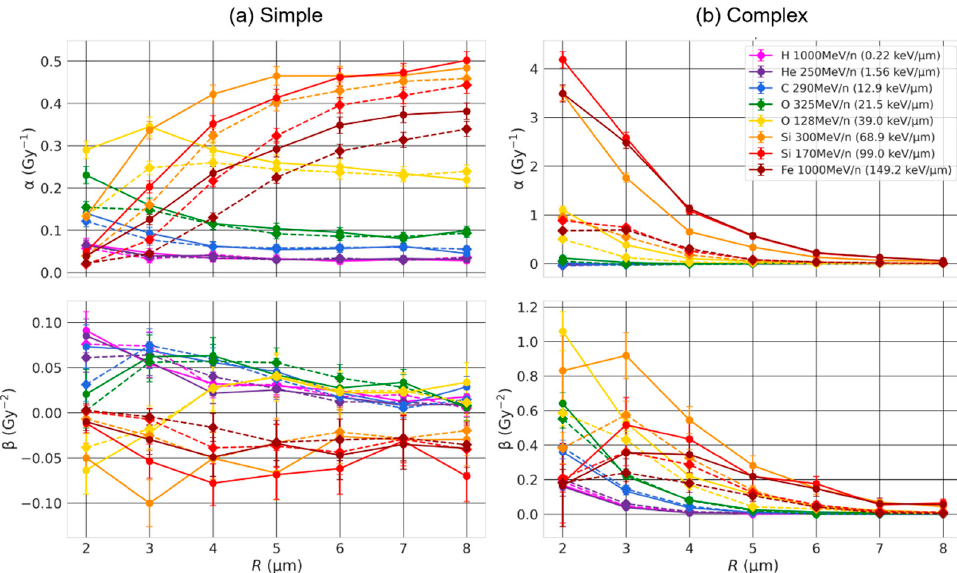
Figure 6. 𝛼 and 𝛽 coefficients of simple ( a ) and complex ( b ) exchanges as a function of the nuclear radius and for different given ion beams. Straight lines were added between RITCARD datapoints to help visualization. Solid line with round symbols: without chromosome domain constraint. Dashed line with diamond symbols: with chromosome domain constraint.